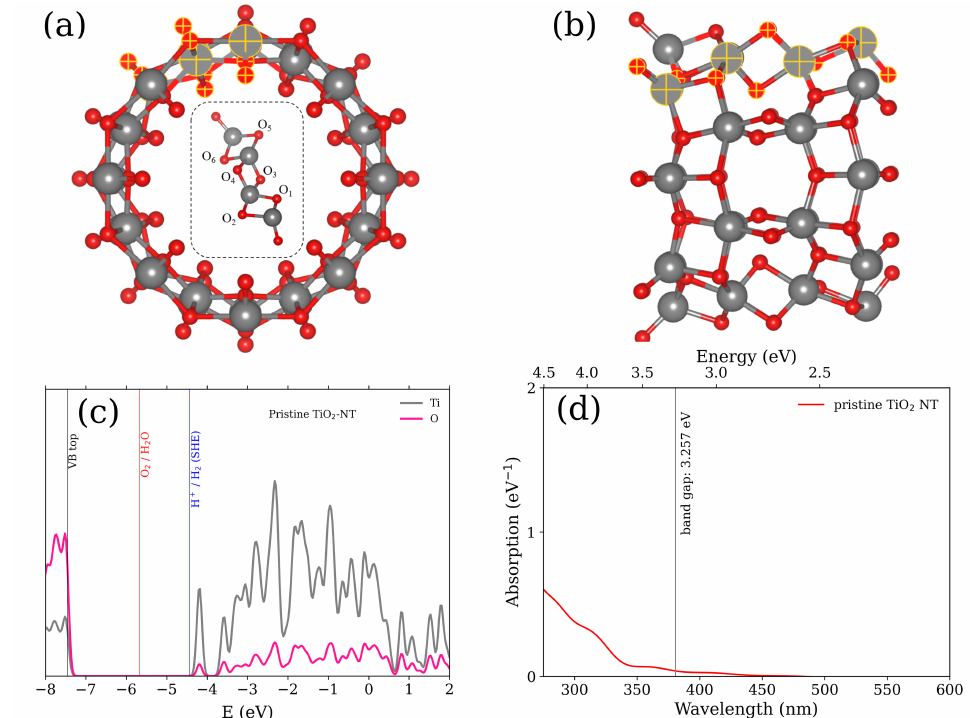
Figure 1. Schematic illustration of the pristine (8,0) anatase (101) TiO 2 NT with the diameter of 0.933 nm: ( a ) front view of the NT, and ( b ) side view of the NT. Ti atoms are shown as gray balls, oxygens are shown as red balls. The inset in ( a ) shows the unit cell of the TiO 2 NT repeated 8 times by rototranslational symmetry. The numbered O atoms denote the doping sites. ( c ) The projected density of states (PDOS) of pristine TiO 2 NT as calculated by means of GLLB-SC exchange–correlation functional within DFT. Vertical black line crossing the DOS plot corresponds to VBM of the pristine TiO 2 NT, while red and blue lines correspond to O 2 /H 2 O and H + /H 2 redox potentials with respect to the vacuum level, respectively. ( d ) is the calculated optical absorption spectrum of the pristine TiO 2 NT. Vertical black line crossing the spectrum corresponds to the band gap width of the pristine TiO 2